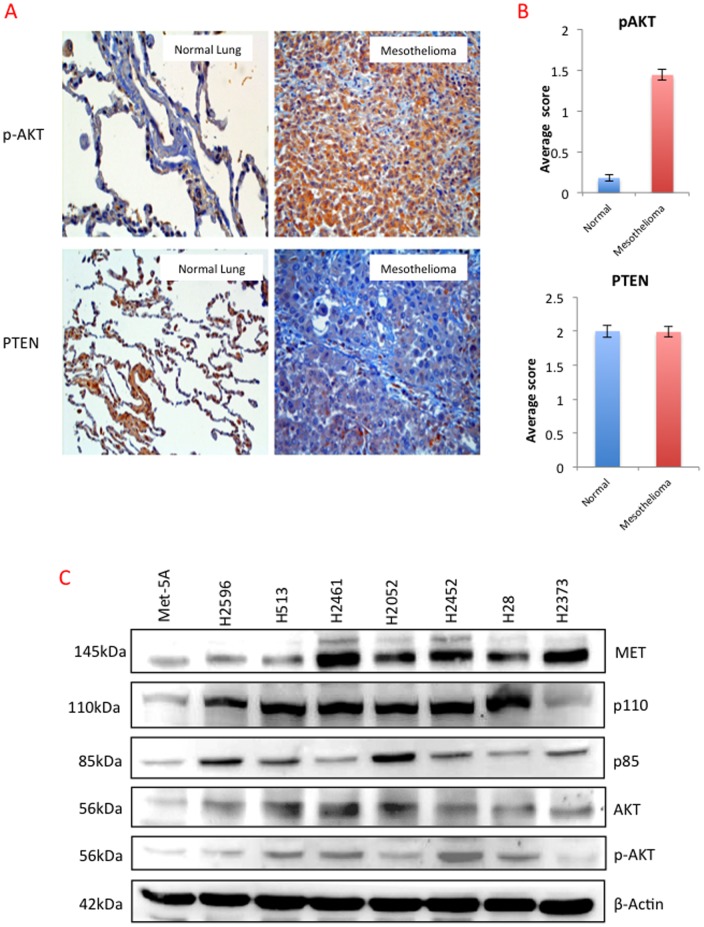
Expression of p-AKT and PTEN in archival mesothelioma tumor tissue samples.Mesothelioma TMA containing 212 tumor samples and 192 normal lung tissue samples probed with p-AKT and PTEN representative images are shown in (A). (B) Comparative average scores of p-AKT and PTEN in TMA samples. (C) Representative immunoblot of mesothelioma cell lines for MET, p-110, p-85, Total AKT, p-AKT and loading control β Actin.